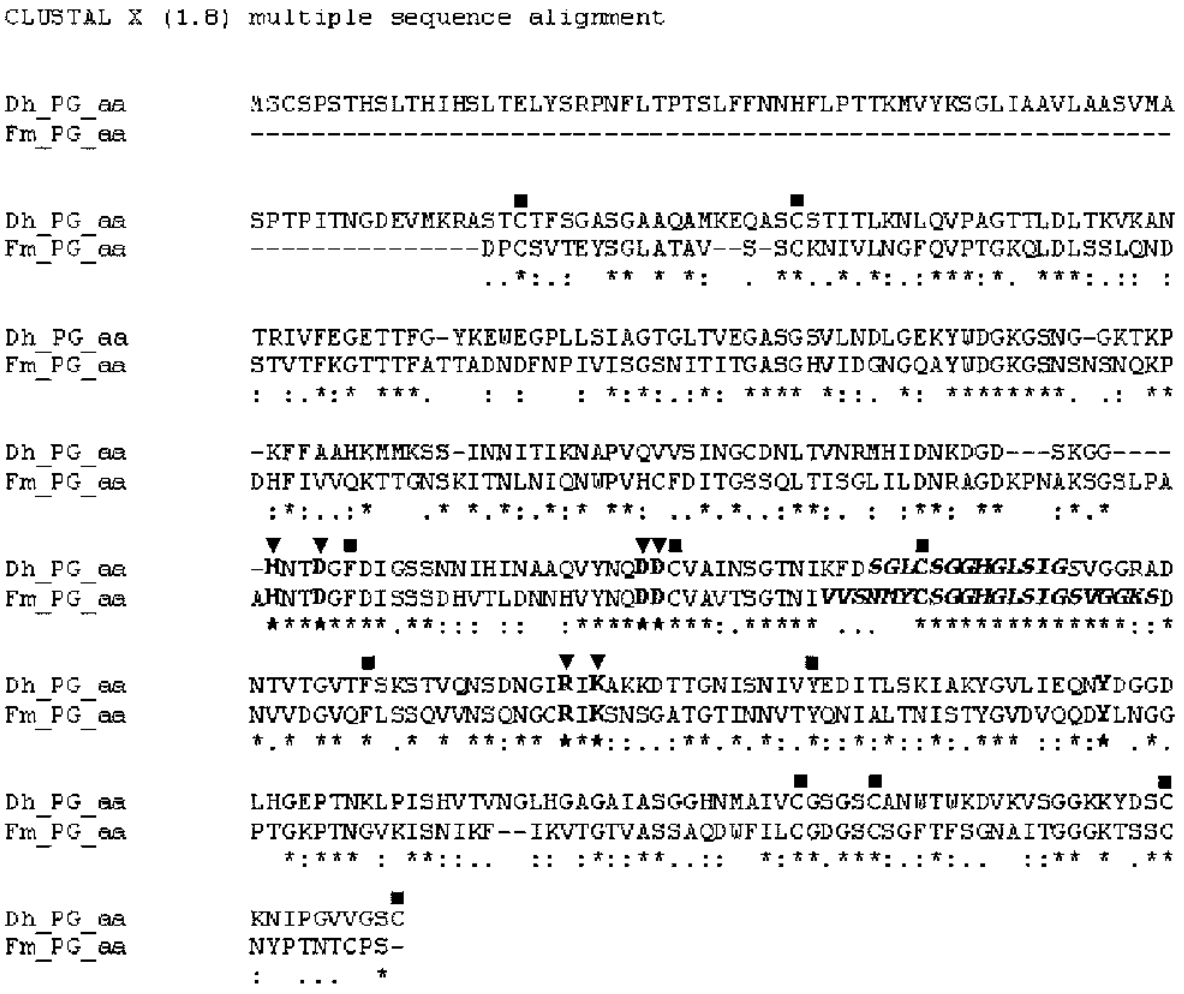
Figure 2b. alignment of Dh Pg vs Fm PG proteins. Active site in bold italics. Aminoacids for specific structure/function:  for β-helical region;  for external regions of active